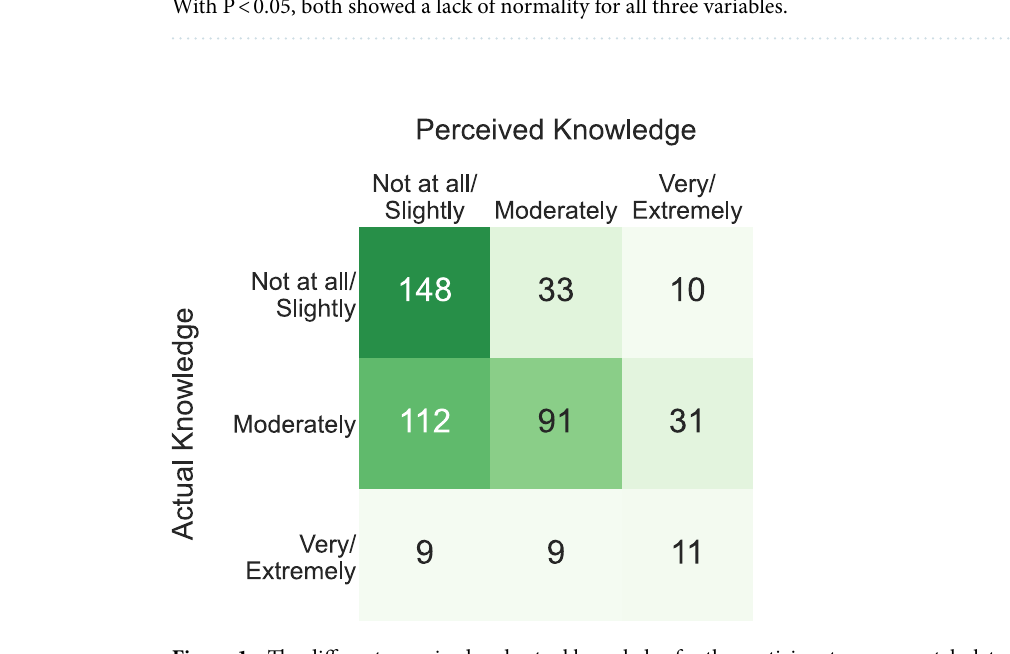
Figure 1. The different perceived and actual knowledge for the participants are cross-tabulated after collapsing the 5-item scales into 3-item